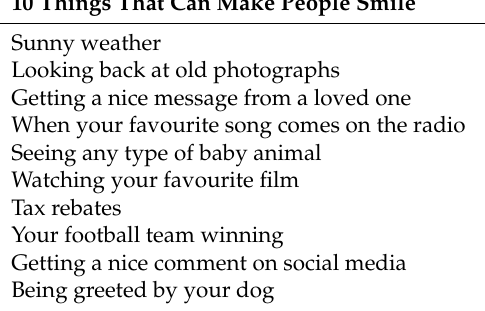
Table 3. Things that can make people